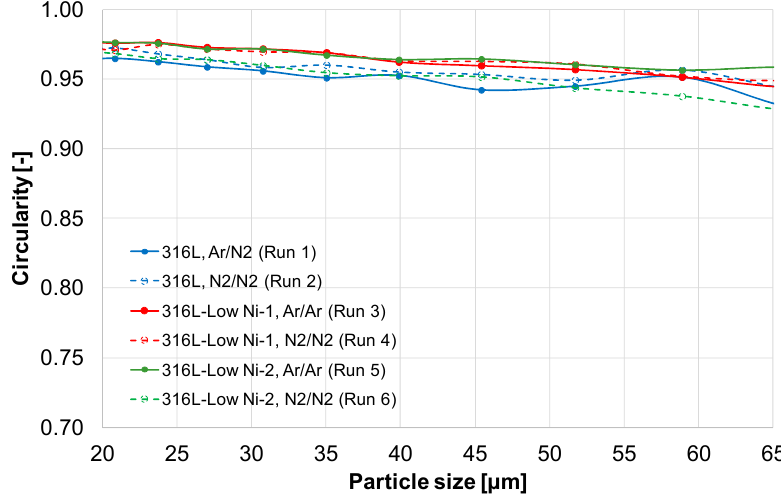
Figure 5. Circularity of the gas atomized 316L and modified 316L steel powders.